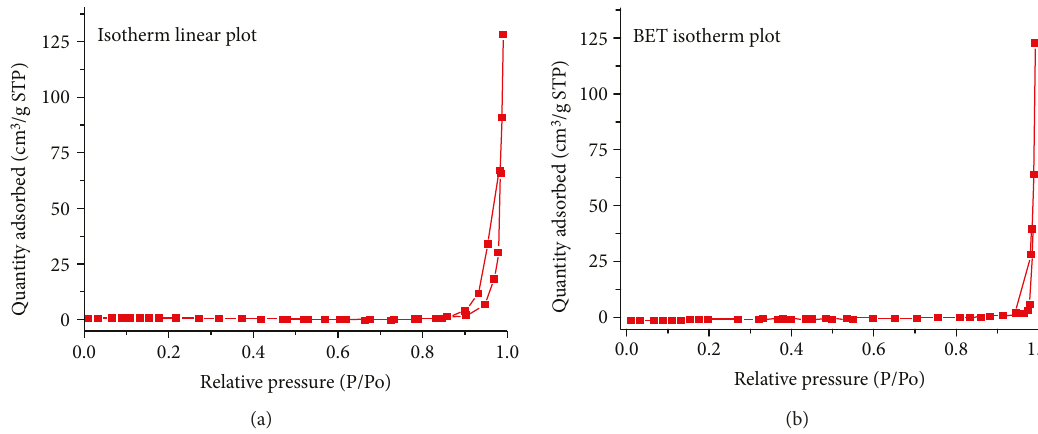
Figure 4: (a) BET isotherm linear plot for polymer composite. (b) Isotherm linear plot for polymer